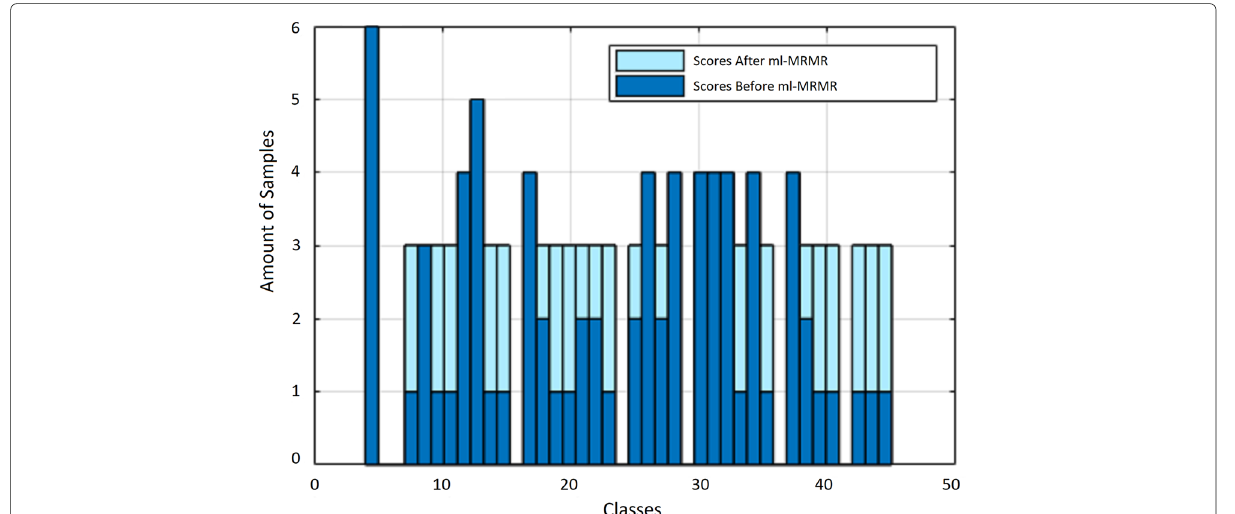
Fig. 1 Sample distribution before and after applying the ml-MRMR algorithm with N min = 3. Turkish database is